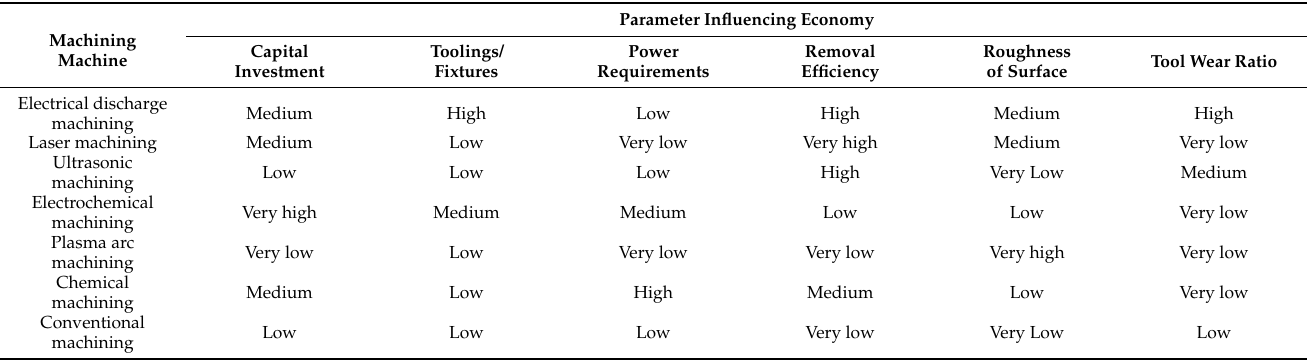
Table 4. Relative comparison between different nontraditional methods. Reprinted/adapted with permission from Ref. [30]. Copyright 2020,